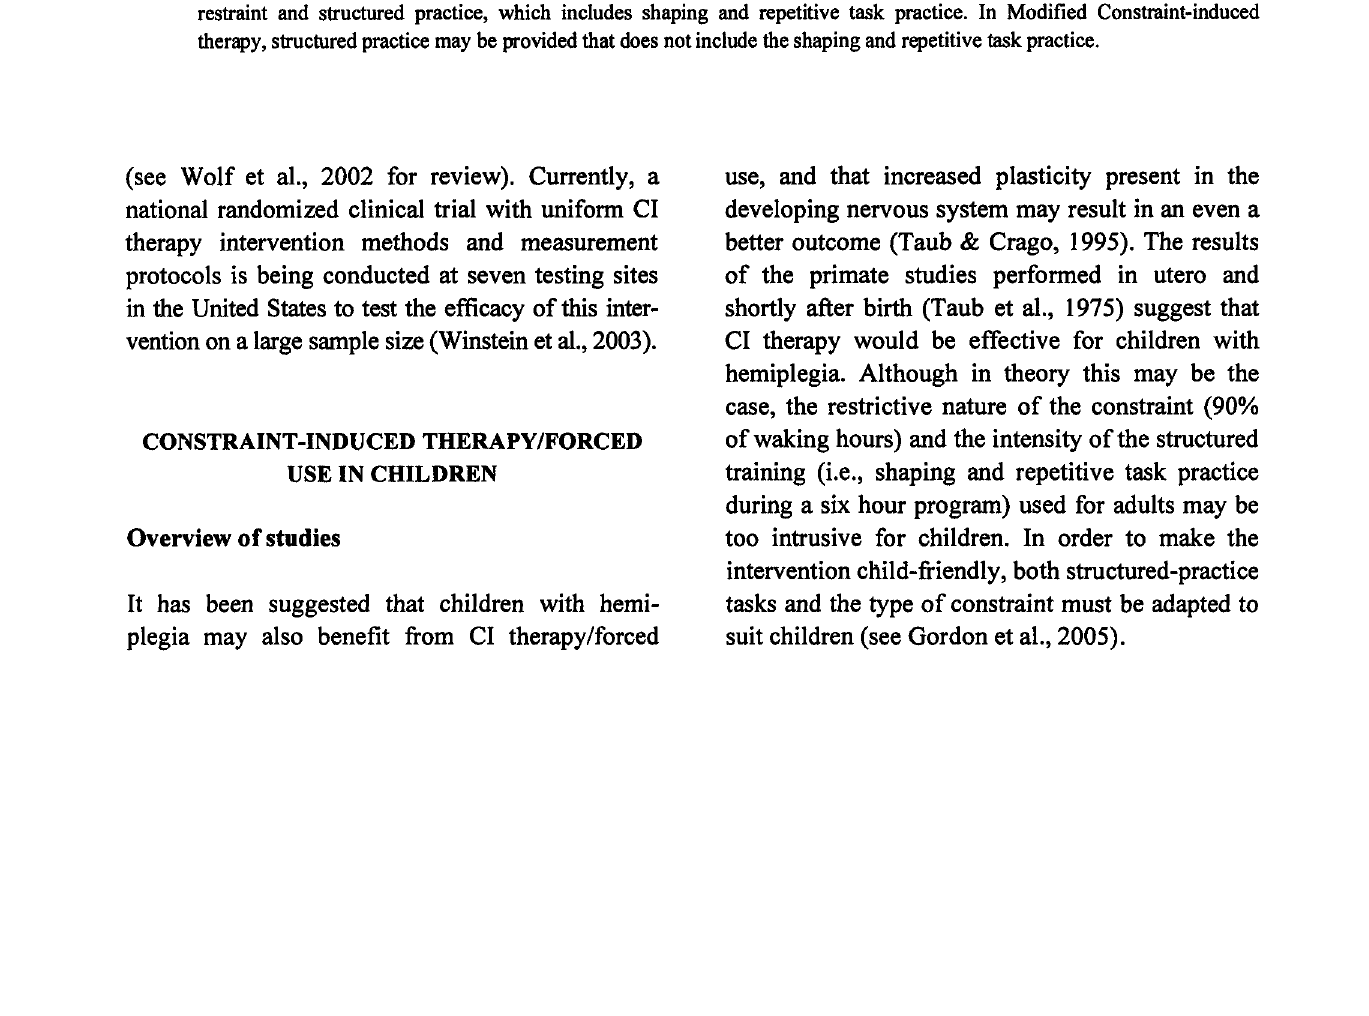
Fig. 1: Restraint therapies: forced use and constraint-induced movement therapy. Forced Use involves a restraint that results in unstructured practice whenever an activity is performed with the involved hand. Constraint-Induced Therapy involves a restraint and structured practice, which includes shaping and repetitive task practice. In Modified Constraint-induced therapy, structured practice may be provided that does not include the shaping and repetitive task